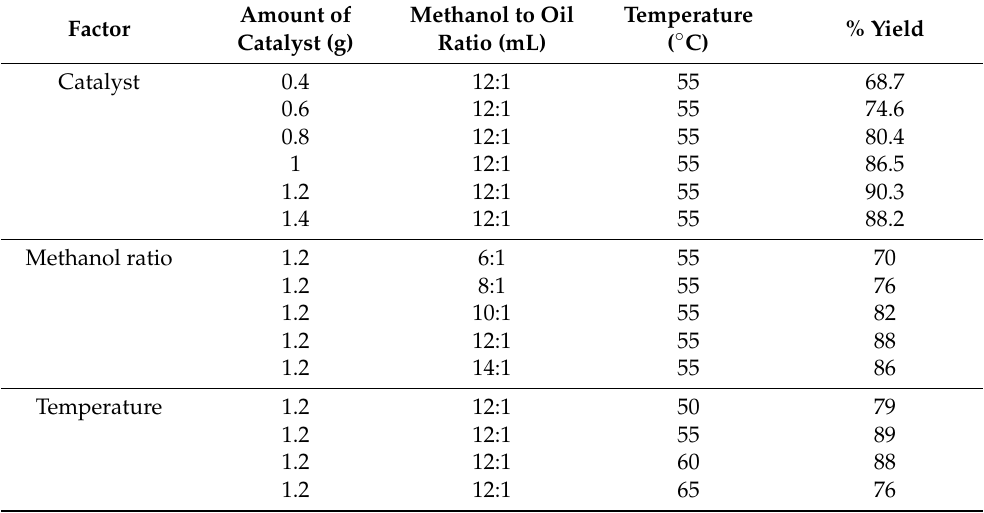
Figure 4. Graph showing the effect of methanol concentration changes on the percentahe yield of biodiesel.